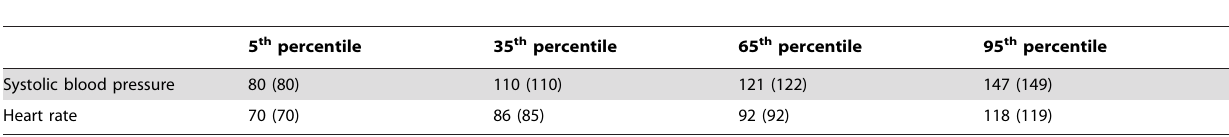
Table 4. Knot positions for systolic blood pressure and heart rate at specified